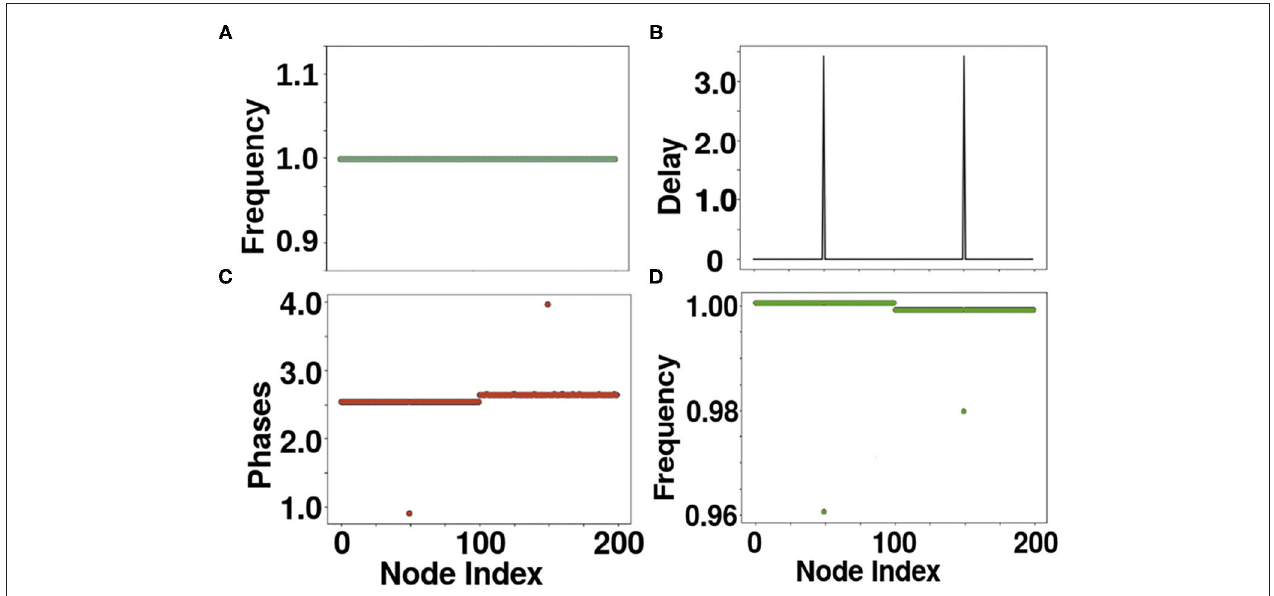
FIGURE 3 | Snapshots of the layers of the multiplex network displaying (A) a flat frequency profile with undelayed inter-layer links (B) introduced delay profile at inter-layer links (C) Phase and (D) frequency profile for the solitary state with introduced delayed interlayer links. System parameters are µ 1 = 0.5, µ 2 = 3 and σ = 1.